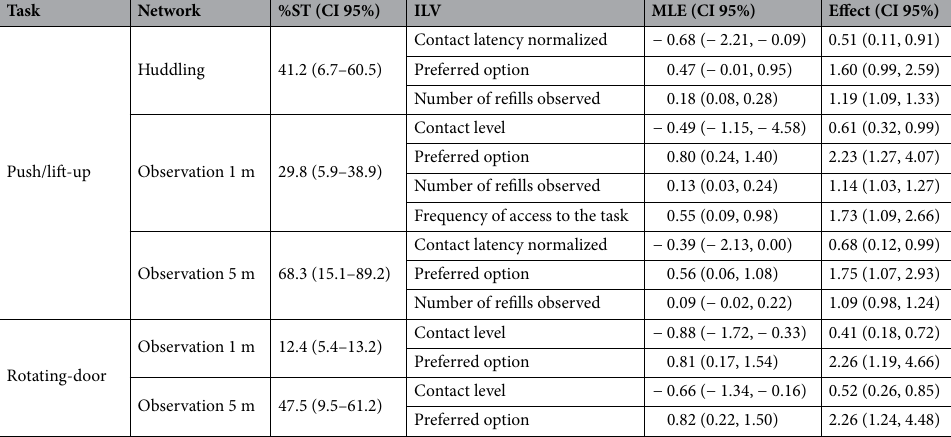
Table 4. Contribution of the s’ parameter and ILVs in social learning for models providing evidence of social transmission in a group of Barbary macaques ( Macaca sylvanus ) at Trentham Monkey Forest (UK). %ST: Percentage of learning events that occurred by social transmission. ILV: Individual level variable. MLE: Maximum likelihood estimate of each parameter. Effect: The degree to which social and asocial learning increase as measures of the parameters (ILVs) increase, calculated as exp(MLE). For example, in the first line social and asocial learning rates decrease by a factor of 0.51 × per 1 s increase of normalized contact latency. For interpretation of CI95%, refer to Table 1 and SI in Hasenjager et al. 26